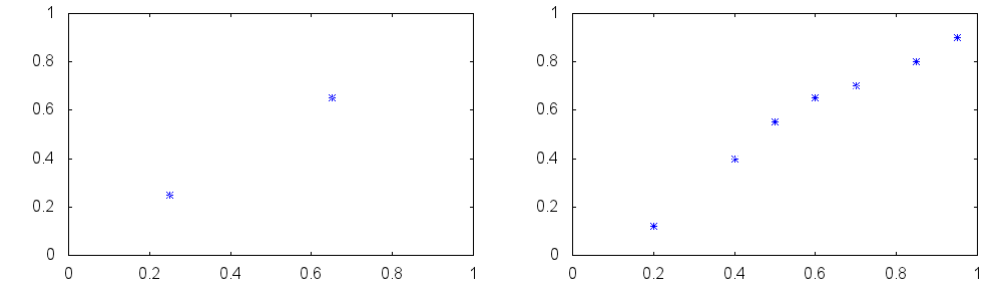
Figure 1. Case (1) in Theorem 3: Two points or an odd number of points.